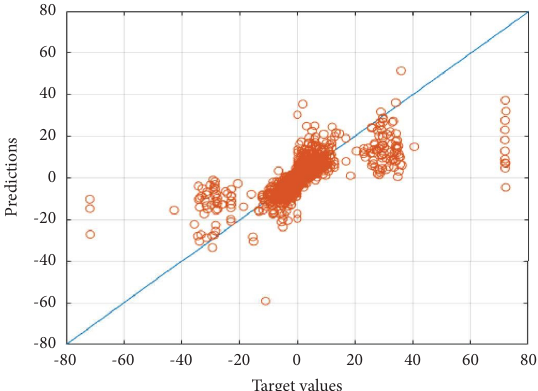
Figure 5: Target values vs. RBF predictions using the proposed features with mating evaluation